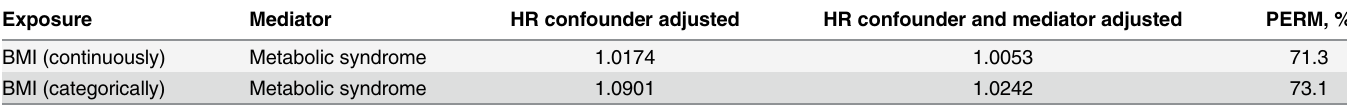
Table 3. Percentage of excess risk mediated by metabolic syndrome in association between body mass index and cardiovascular